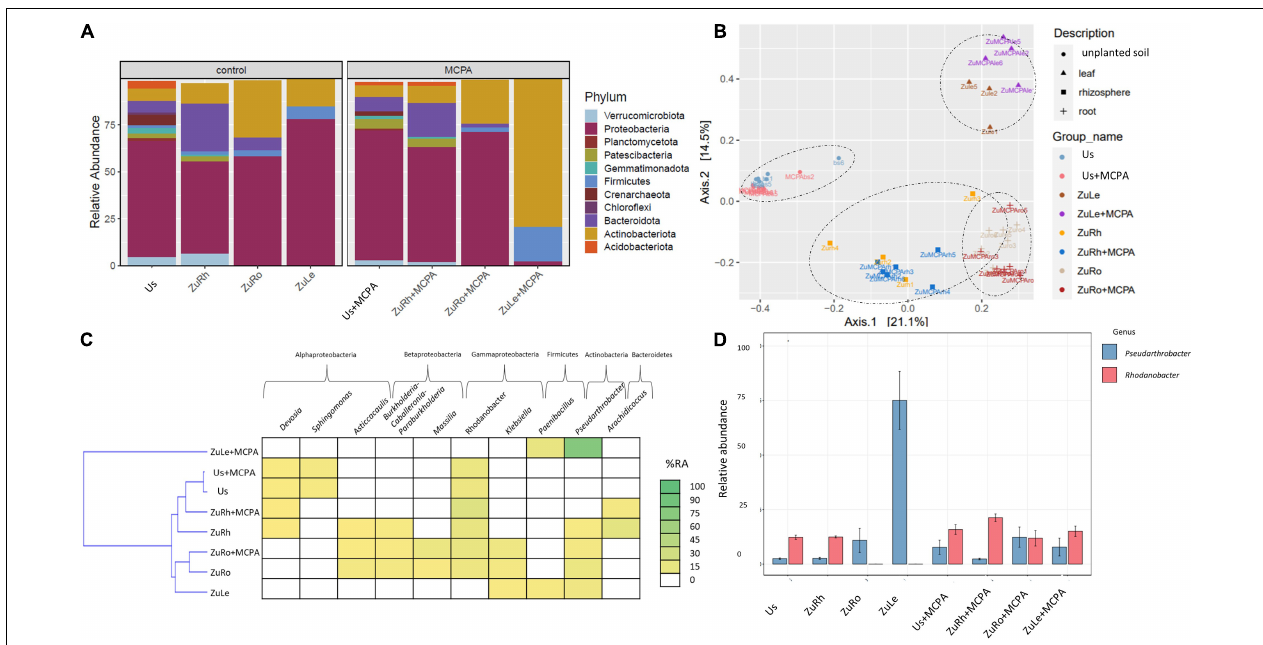
FIGURE 3 | Bacterial community structure based on 16S rRNA gene sequence for MCPA-amended variants in comparison to untreated variants: (A) Relative abundances (%) of the bacterial community at the phylum level; (B) PcoA ordination plots of the results based on the Bray–Curtis distances of the classified 16S rRNA gene sequences; (C) Heat map of top 10 genera in each treatment; (D) Relative abundance (%) of Pseudarthrobacter and Rhodanobacter in the different treatments. Variants: Us, unplanted soil; ZuRh, zucchini rhizosphere soil; ZuRo, zucchini root; ZuLe, zucchini leaves; Us + MCPA, unplanted soil treated with MCPA; ZuRh + MCPA, zucchini rhizosphere soil treated with MCPA; ZuRo + MCPA, zucchini root from soil treated with MCPA; ZuLe + MCPA, zucchini leaves from soil treated with